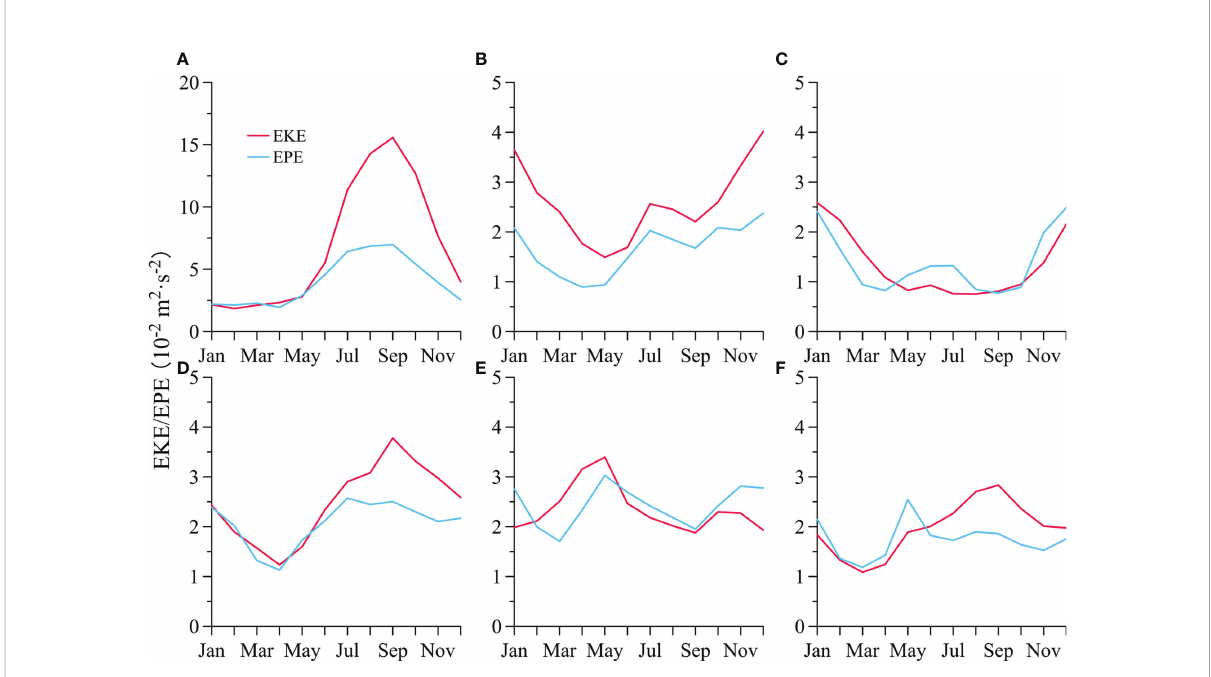
FIGURE 3 Monthly variation of eddy kinetic energy (EKE) and eddy potential energy (EPE) averaged in the A1 (A) , A2 (B) , A3 (C) , B1 (D) , B2 (E) , and B3 (F)